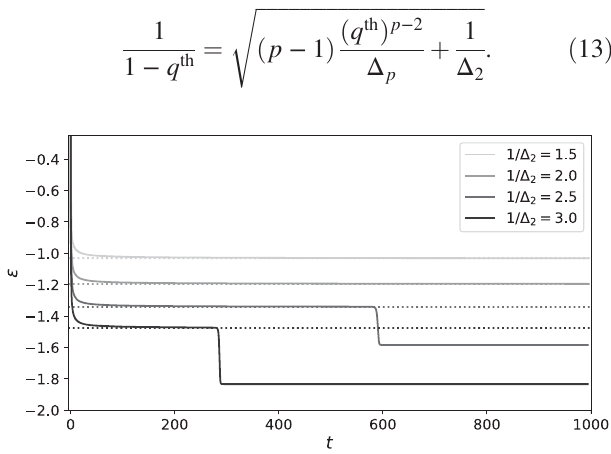
FIG. 5. Dynamical evolution of the energy starting from a configuration with overlap 10 − 40 at Δ The system first tends to the threshold energy [Eq. (12), horizontal lines] and then, for sufficiently small Δ 2 , finds the direction toward the